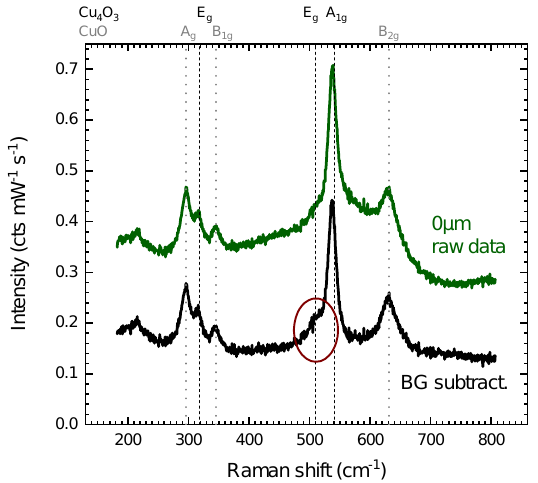
Figure 4. Raw data and background-subtracted data of the 10nm Cu x O sample, using the described focal shift method. In subtracted data Raman modes of the copper oxide are seen as more symmetric and smaller modes (red circle) can be identified. The effect of the background subtraction is limited, as the thin film signal is very strong for this reference